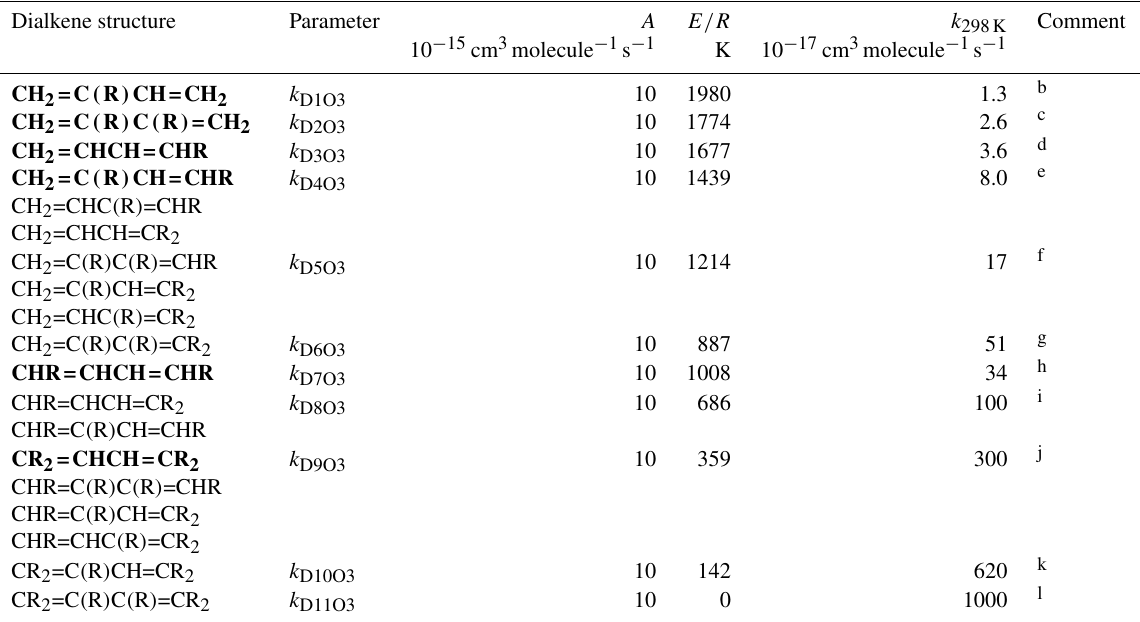
Table 4. Arrhenius parameters ( k = A exp ( − (E/R)/T )) for the rate coefficients for O 3 addition to generic conjugated dialkene structures, and the rate coefficient values at 298K a